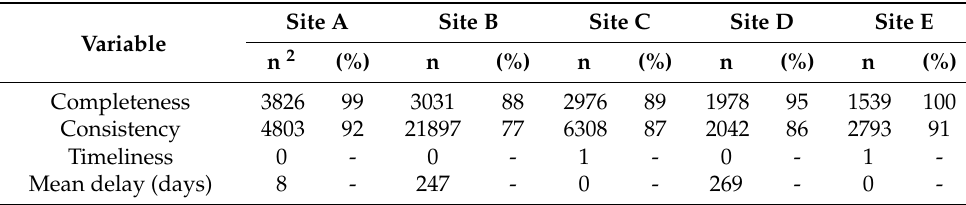
Table 4. Difference in completeness, consistency, and timeliness (with report submission delay) from five AMR 1 surveillance sites in Province 3 of Nepal (January to June